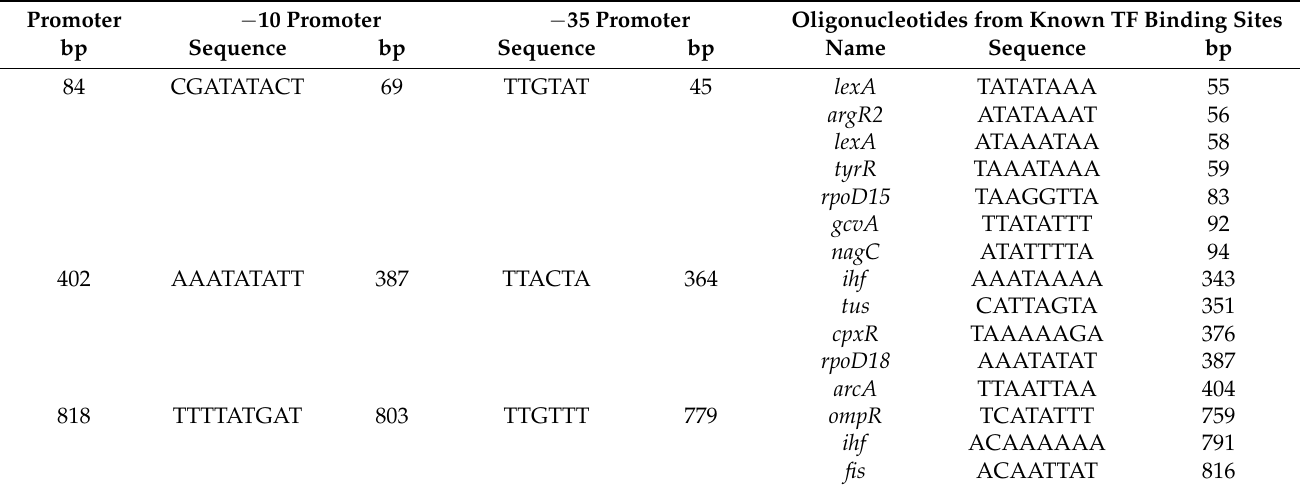
Figure 5. Schematic of potential promoter and transcription factor binding sites upstream of psoR . Predicted promoter and transcriptional factor binding sites for psoR shown with upstream gene tcpA . The BPROM program [41] was used to analyze the potential promoter and transcription factor binding sites associated with the F. diplosiphon tcpA - psoR genomic region. The sequence analyzed was retrieved from the NCBI database (accession ID: DQ286230.1). In the figure, − 10 and − 35 promoter sites are indicated by arrowheads, while the predicted transcription factor binding sites are indicated by color-coded symbols. Table 3. List of potential promoter sites and transcription factor binding sites upstream of psoR in Fremyella diplosiphon . The sequence containing the upstream region of psoR had three predicted promoter regions. Potential transcription factor binding sites were also found, with binding sequences and locations indicated. Bp = base pairs; TF = transcription factor.